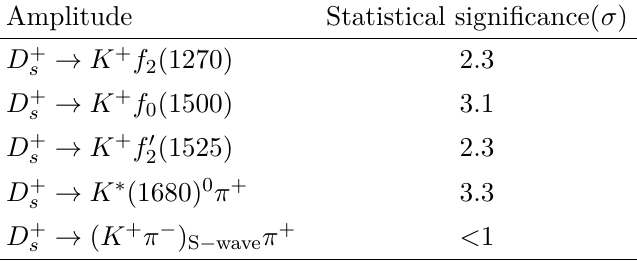
→ K + f 0 (980) , V D + s